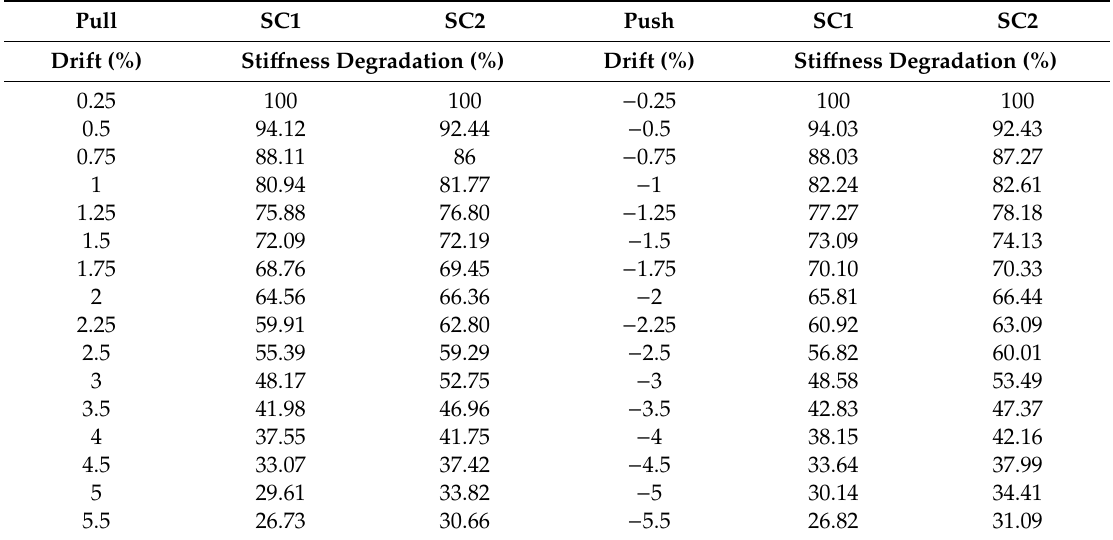
Figure 12. Sti ff ness degradation ratio. Figure 12. Stiffness degradation ratio. Table 4. Joint-sti ff ness Table 4. Joint-stiffness degradation.